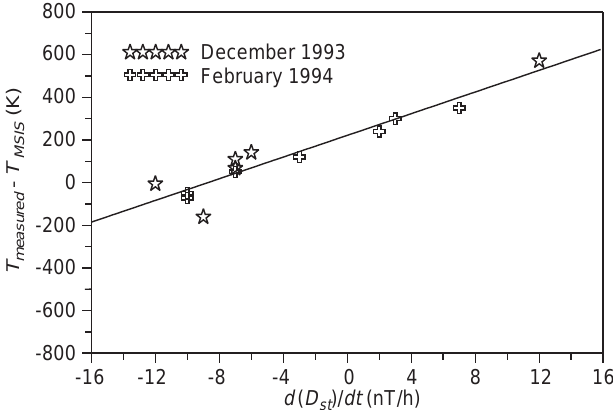
Fig. 3. Scatter plot considering temperatures on 8 December 1993 and 5